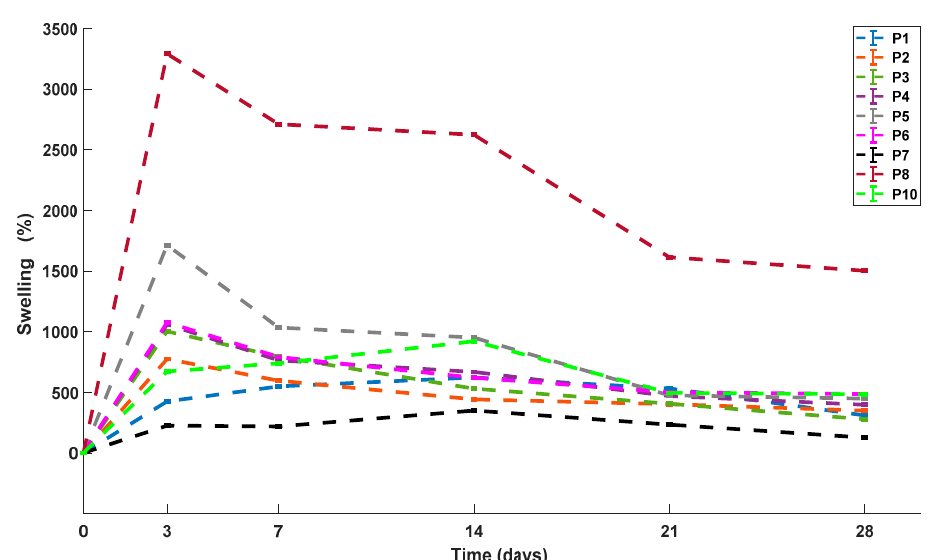
Figure 8. Swelling percentages of ternary blend scaffolds and controls.